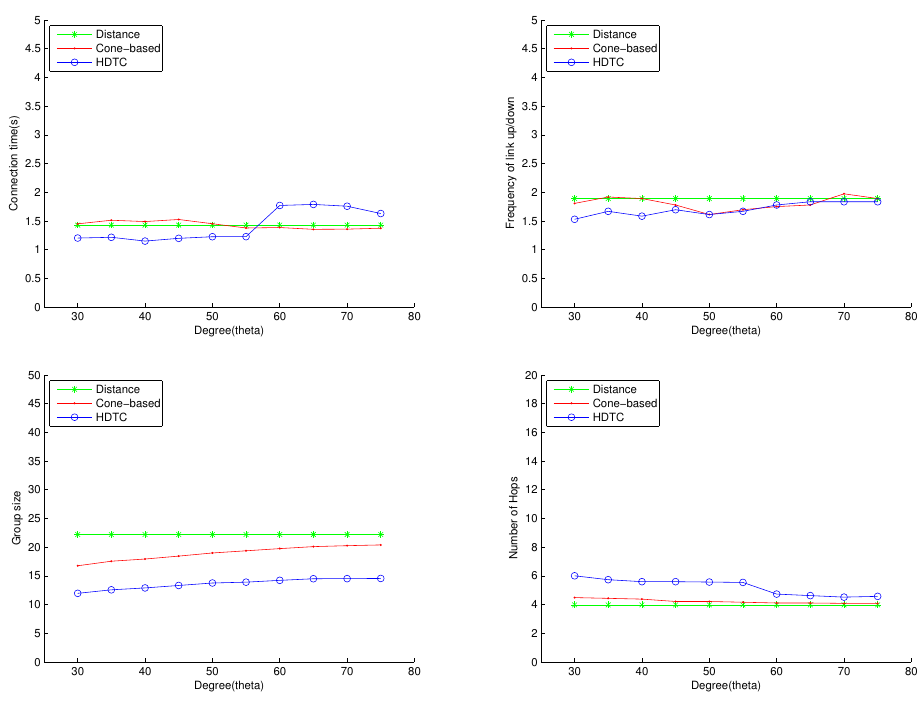
Figure 13. Scenario 1: The connection time, the frequency of the link up/down, the group size and the number of hops with varying θ .